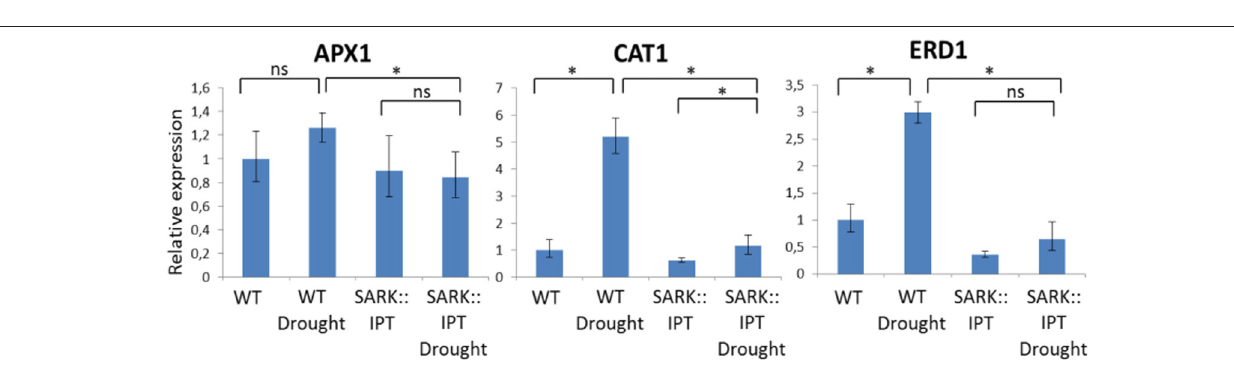
FIGURE 2 | Relative expression of APX1 , CAT1, and ERD1 genes in w.t. and transgenic SARK::IPT plants during drought stress. Arabidopsis plants were grown for 40 days in optimal conditions and were then transferred to drought stress for 7 days. Controls were well - watered plants (w.t. and transgenic). The qPCR assay reflects relative expression levels for each gene and was performed in triplicate for each of the three independent biological samples. Expression of each of the tested genes in the control treatment of w.t. plants was used as the basis for comparison (relative expression = 1). Horizontal brackets denote significance of P < 0.05 (*, statistical significance; ns, no